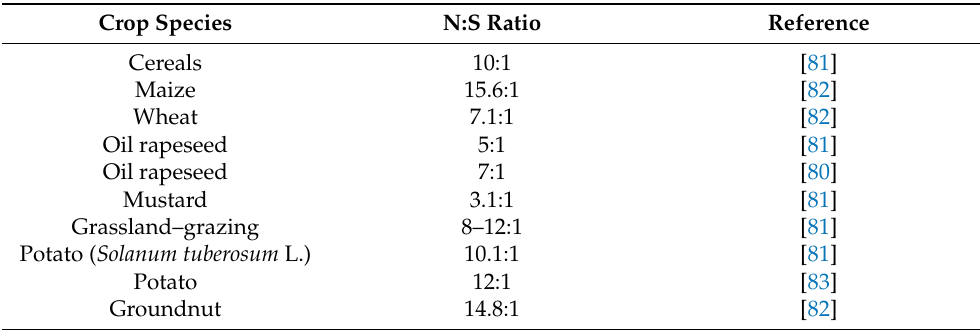
Table 1. N:S ratios in plant tissues of different